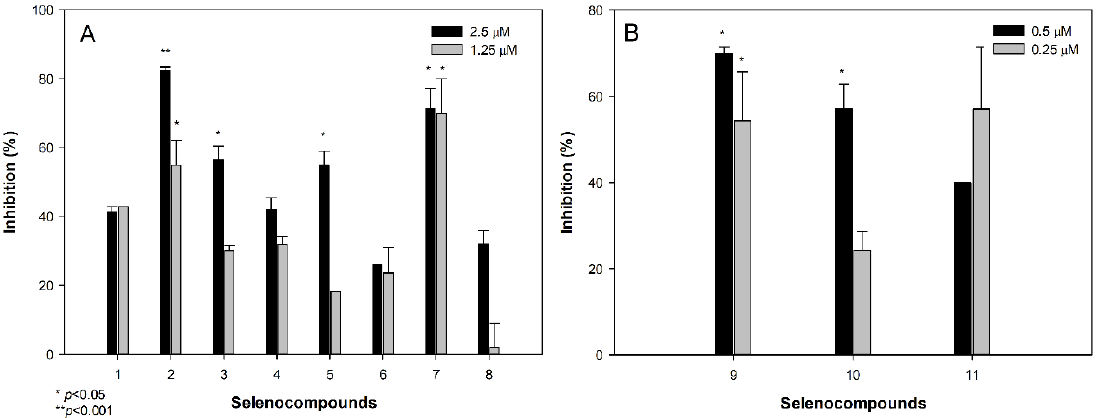
Figure 1. Anti-chlamydial effect of selenocompounds at 1.25 and 2.5 μM ( A ), and at 0.25 and 0.5 μM ( B ).